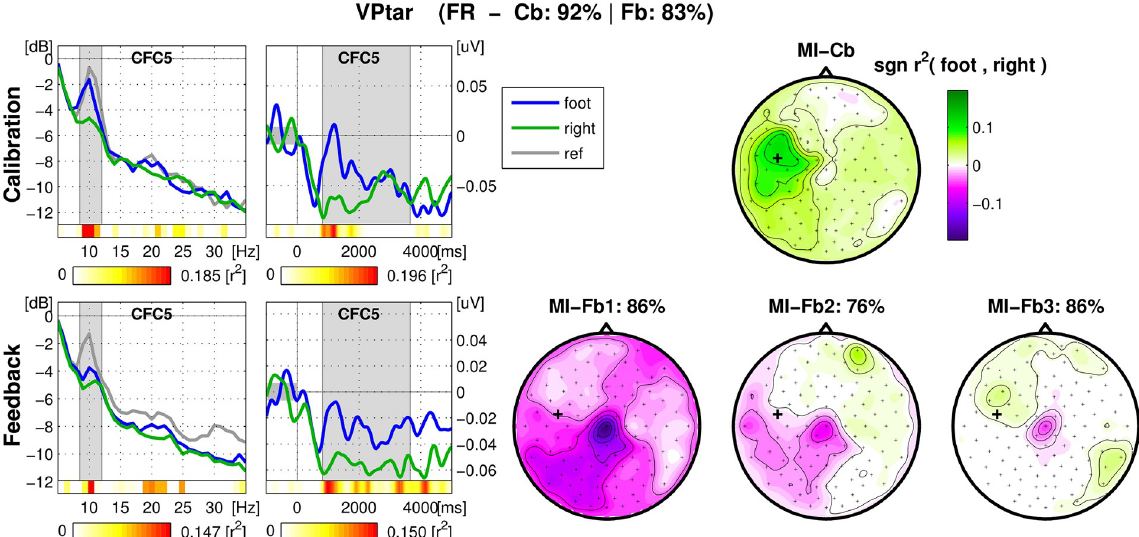
Fig 5. Overview figure of calibration and feedback runs for an exemplary user. Example of development of correct foot SMR pattern during MI-Fb session and of ERD for both classes prior to a resynchronization for the class Foot class. Also, it is visible how the feedback helped to maintain the ERD longer. From left to right, spectra, ERD and scalp plot of r 2 -values. Top: calibration data. Bottom: feedback data. See caption of Fig 4 for